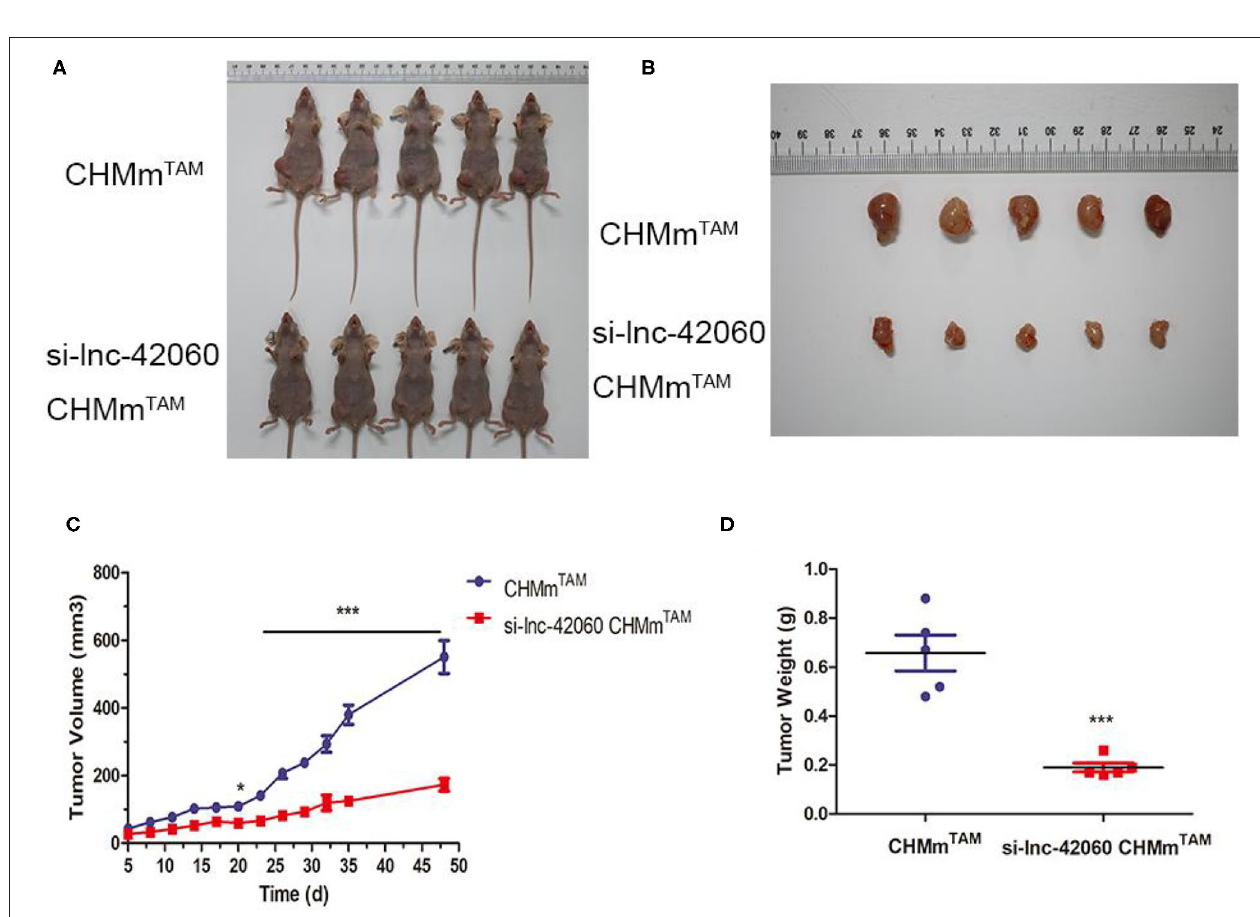
FIGURE 8 | Knocking down lnc-42060 reduces tumorigenesis of CHMm TAM in vivo . CHMm TAM /si-lnc-42060 CHMm TAM cells infected were subcutaneously injected into nude mice. (A,B) Comparison of tumor size between CHMm TAM and si-LNC-42060 CHMm TAM cells after inoculation in mice. (C) Tumor volumes were examined every 3 days for 48 days. (D) Tumor weight were examined on day 48. Compared with control group, *** P <